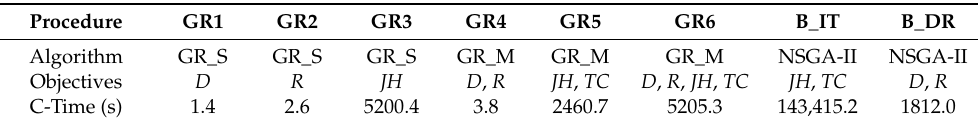
Table 1. The procedures and the required computational time (C-Time) for the test with 14 sensors and detection threshold (0.0001